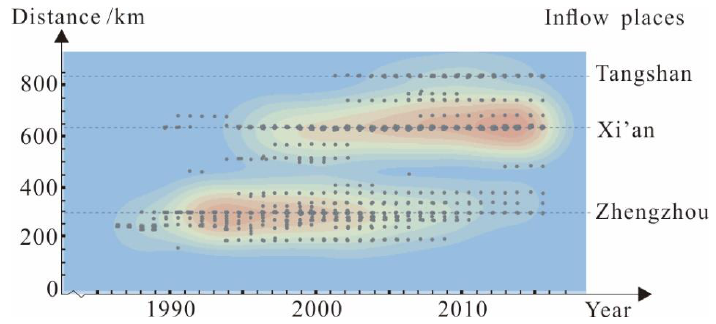
Figure 4. Changes of inflow places in Village A.